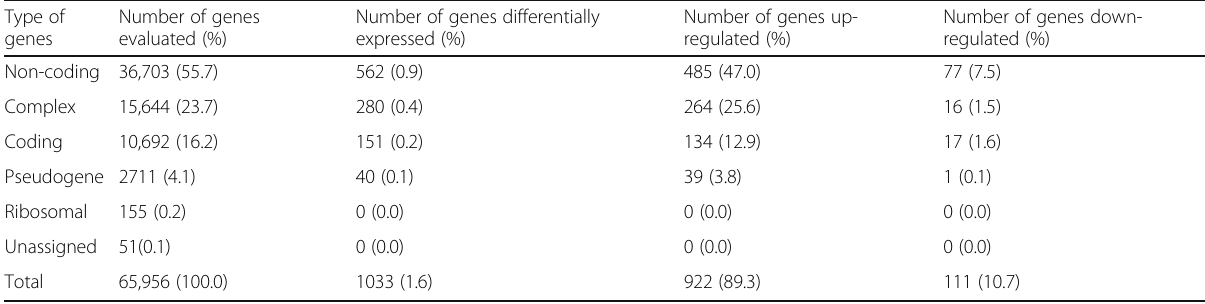
Table 1 Summary of gene level differential expression analysis in RPE samples in two different conditions ( Prpf31 A216P/+ vs WT mice). Default filter criteria, fold change < − 2 or > 2 and ANOVA p -value <